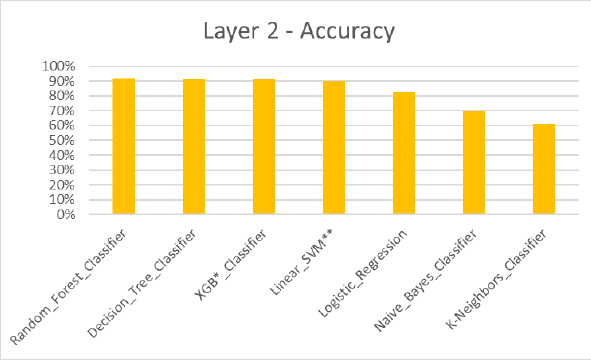
Figure 5. Layer 2 for prediction of extraction and non-extraction treatment for jaw base I—accuracy. * XGB—eXtreme Gradient Boosting. ** SVM—Support Vector Machine.